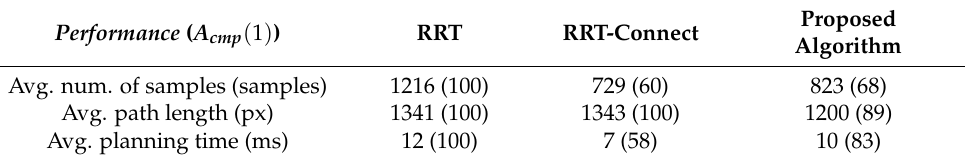
Table 2. Experimental result of Map 1 (the parentheses to the right of each value are relative ratios based on RRT 100% ( x cmp ( 1 ) )).